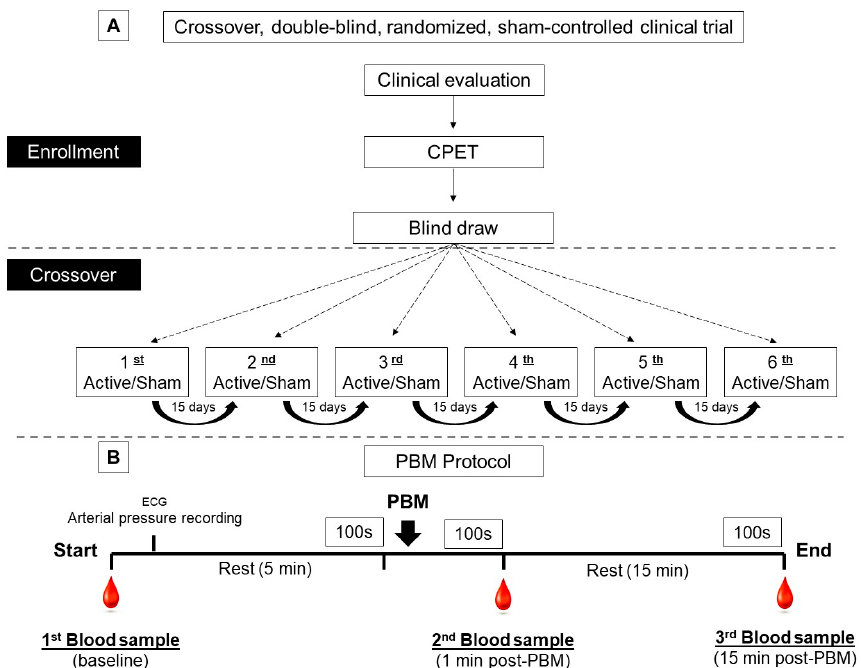
Figure 1. ( A ) The participants were submitted to a clinical evaluation consisting of blood assays and clinical cardiopulmonary exercise testing (CPET). After screening, the photobiomodulation (PBM) active or sham corresponding to each session was randomly selected and respecting 15 days of interval between sessions. ( B ) On the day of the experimental protocol, subjects were monitored and positioned in a sitting position at rest and the first blood sample was performed for fasting plasma glucose and lactate concentration analysis. After 5 min at rest, the PBM (active or sham) was applied, and a blood sample was collected 1 min and 15 min post PBM irradiation.